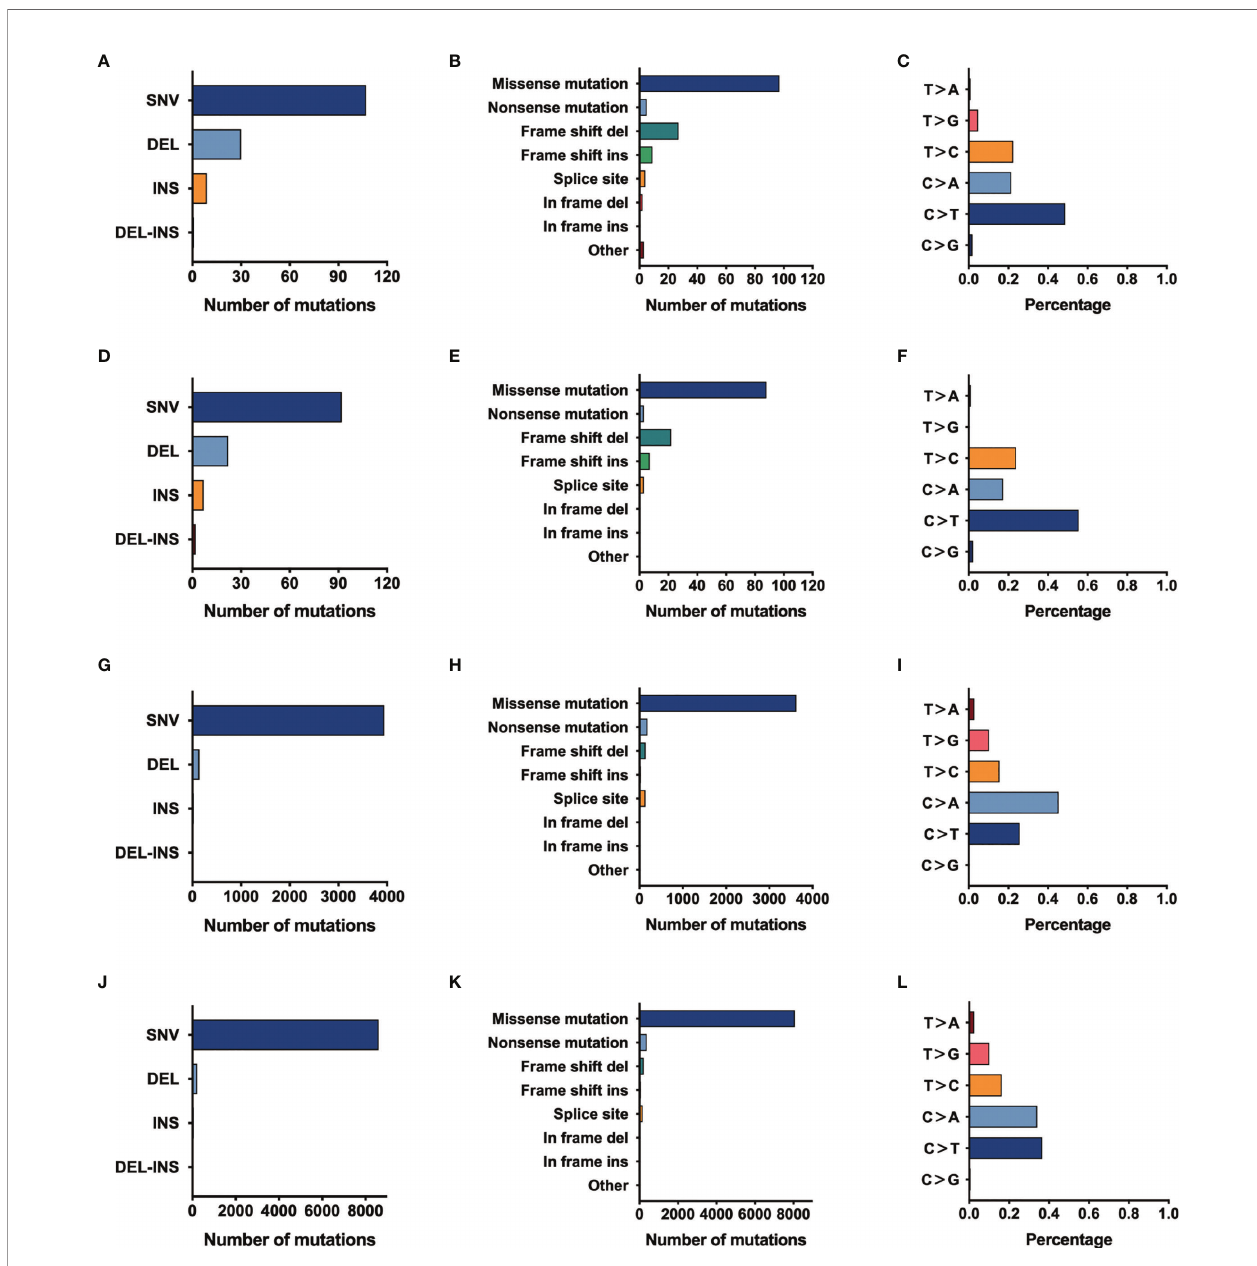
FIGURE 3 | The mutational pattern of MC-5, MP-13, P-PP-1, and P-PV-6. (A – C) Total number of mutations detected by variant type, variant classi fi cation, and single-nucleotide variant (SNV) class in MC-5. (D – F) Total number of mutations detected by variant type, variant classi fi cation, and SNV class in MP-13. (G – I) Total number of mutations detected by variant type, variant classi fi cation, and SNV class in P-PP-1. (J – L) Total number of mutations detected by variant type, variant classi fi cation, and SNV class in